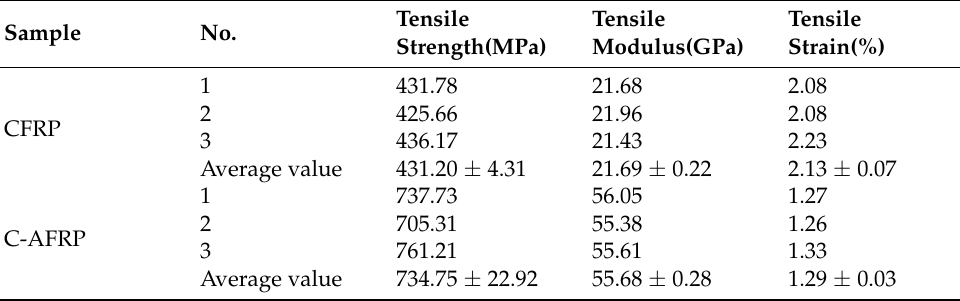
Figure 6. Stress–strain curves of ( a ) CFRP and ( b ) C-AFRP. Table 2. Tensile test results.